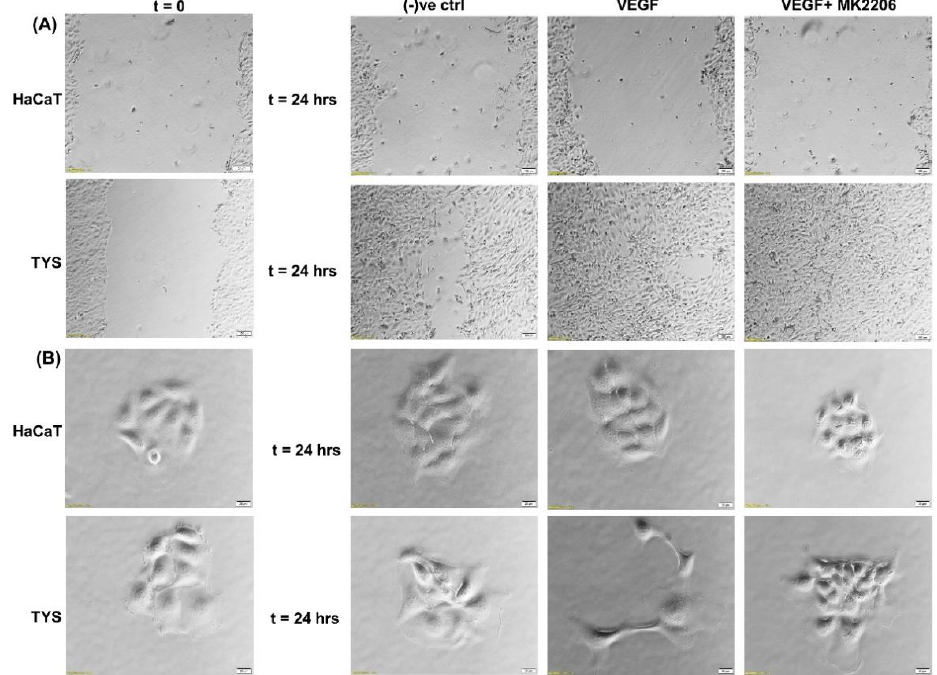
Figure 6. Oral cancer cell migration in response to VEGF. ( A ) VEGF ± inhibitor was used in the wound healing assay for 24 h. VEGF stimulated TYS migration in the wound healing assay in comparison to the negative control. The Akt inhibitor, MK2206, effectively blocked VEGF-induced oral cancer cell migration. HaCaT cells were not stimulated to migrate in response to VEGF. Se- rum-free medium was used as the negative control. Images were captured at t = 0 and 24 h at 50× magnification. ( B ) Test conditions were applied in the scatter assay for 24 h. VEGF stimulated TYS cells to migrate away from the compact colonies and a mesenchymal-like cell morphology was ob- served in the scattered cells. MK2206 effectively blocked VEGF-induced scattering of oral cancer cells. HaCaT cells were not stimulated to scatter in response to VEGF. Serum-free medium was used as the negative control. Images were captured at t = 0 and 24 h at 200× magnification. An in- verted microscope (Olympus IX70, Tokyo, Japan) with a brightfield camera (SC50) was used to capture the images and CellSense software (Olympus) was used to process the images. The exper- iments were carried out more than 3 times. 6. Nerve Growth Factor (NGF) NGF is a neurotrophic factor which was the first growth factor discovered in cancer biology by Levi-Montalcini in the 1940s, as a substance secreted by a mouse sarcoma in 3-day-old chick embryos, that stimulated neurite outgrowth and neural survival [124]. NGF is produced by the central and peripheral nervous system and immune cells. The largest amount of the neurotrophin is produced in the submaxillary glands [125]. NGF is a member of the neurotrophins family, which also includes brain-derived neurotrophic factor (BDNF), neurotrophin-3 (NT-3), and NT-4/5 [126]. The history of NGF and other neurotrophic factor research is strongly associated with the field of neu- roscience, where NGF promotes survival, differentiation, and functional activity of pe- ripheral sensory and sympathetic nerve cells [127]. There are non-neural functions of NGF outside its classical duty in the peripheral and central nervous system, for example, roles in the development of the reproductive system, the endocrine, cardiovascular, and immune systems [128]. Moreover, NGF has protective and treatment roles in Alz- heimer ’s disease [129], corneal ulcers, and glaucoma [130]. Recent progress in NGF re- search has shown that NGF has a role in carcinogenesis and the pathogenesis of many tumours by regulating cell proliferation, invasion, and therefore cancer cell survival